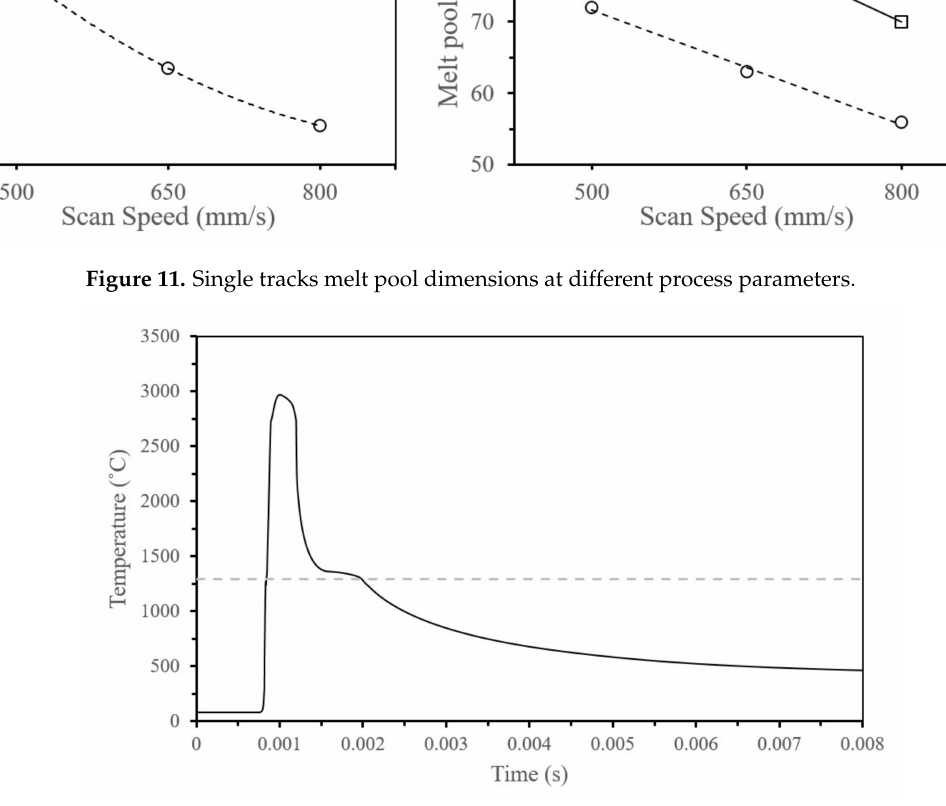
Figure 12. Temperature history evolution for a single track.